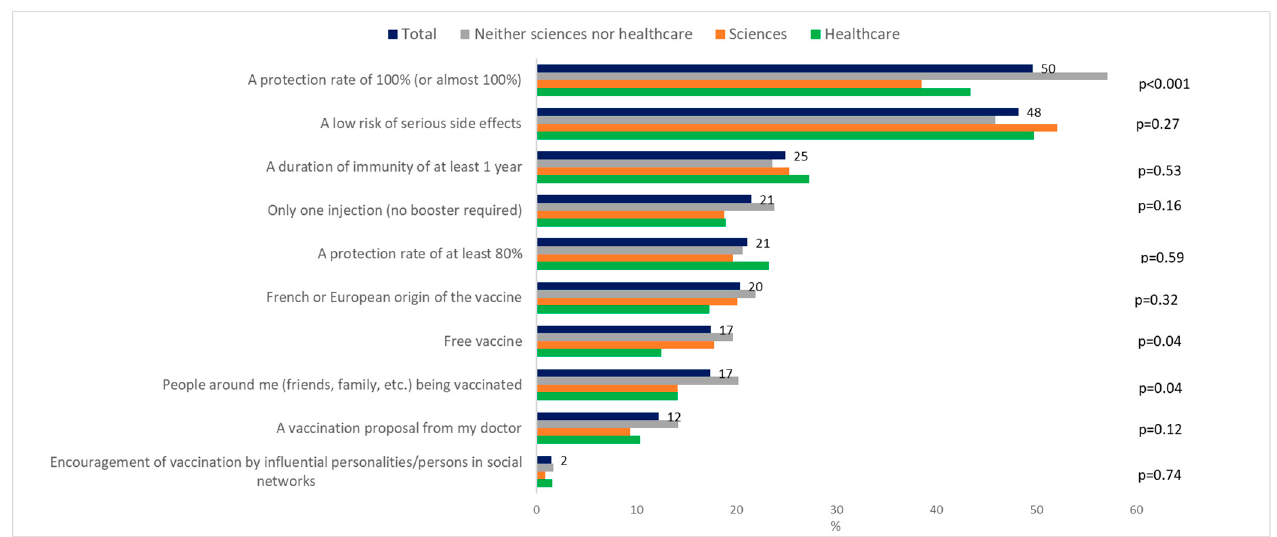
Figure 4. University student’s barriers of COVID-19 vaccine hesitancy or vaccine resistancy ( N = 1299).